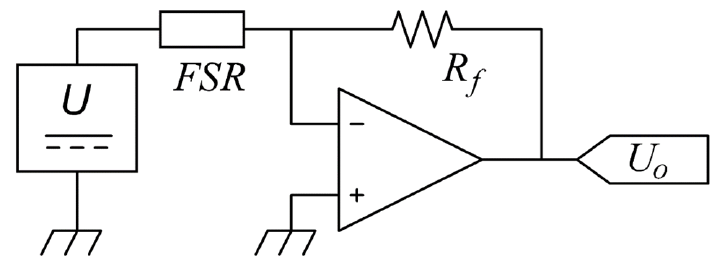
Figure 2. Electrical setup for driving the FSRs. The input voltage ( U ) was implemented from a digital-to-analog converter (DAC) to enable sensor characterization at multiple voltages.